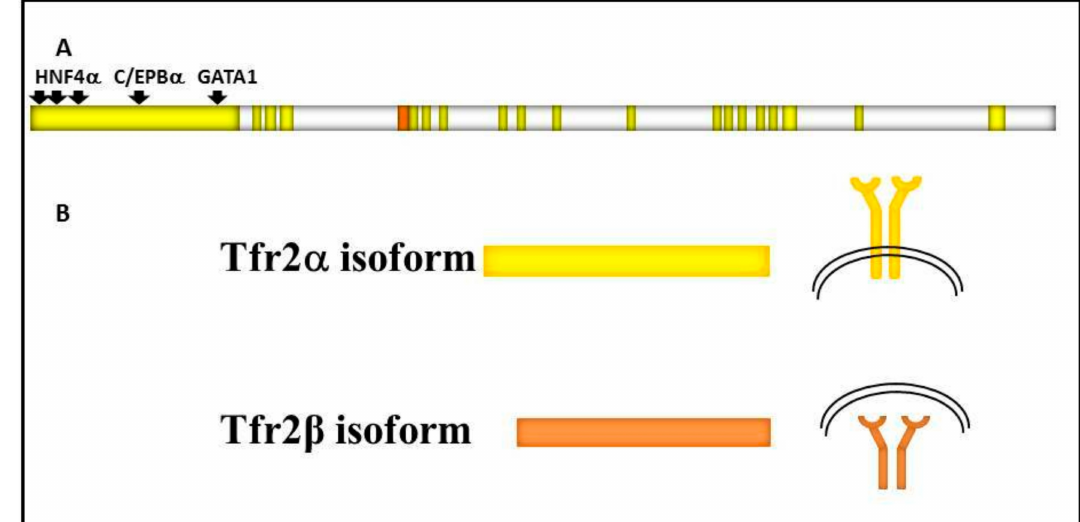
Figure 1. Schematic representation of: ( A ) TFR2 gene structure. TFR2 18 exons are in bright yellow, TFR2 α promoter is shown upstream of the gene, and transcriptional factors binding sites are highlighted by black arrows. 5 (cid:48) untranslated region (142 bp long) of TFR2 β transcript is shown in orange; ( B ) the two main transcripts and of Tfr2 α and Tfr2 β isoforms, that are identical in the common sequence, and the two protein localizations, on the cell surface or in the cytosol,